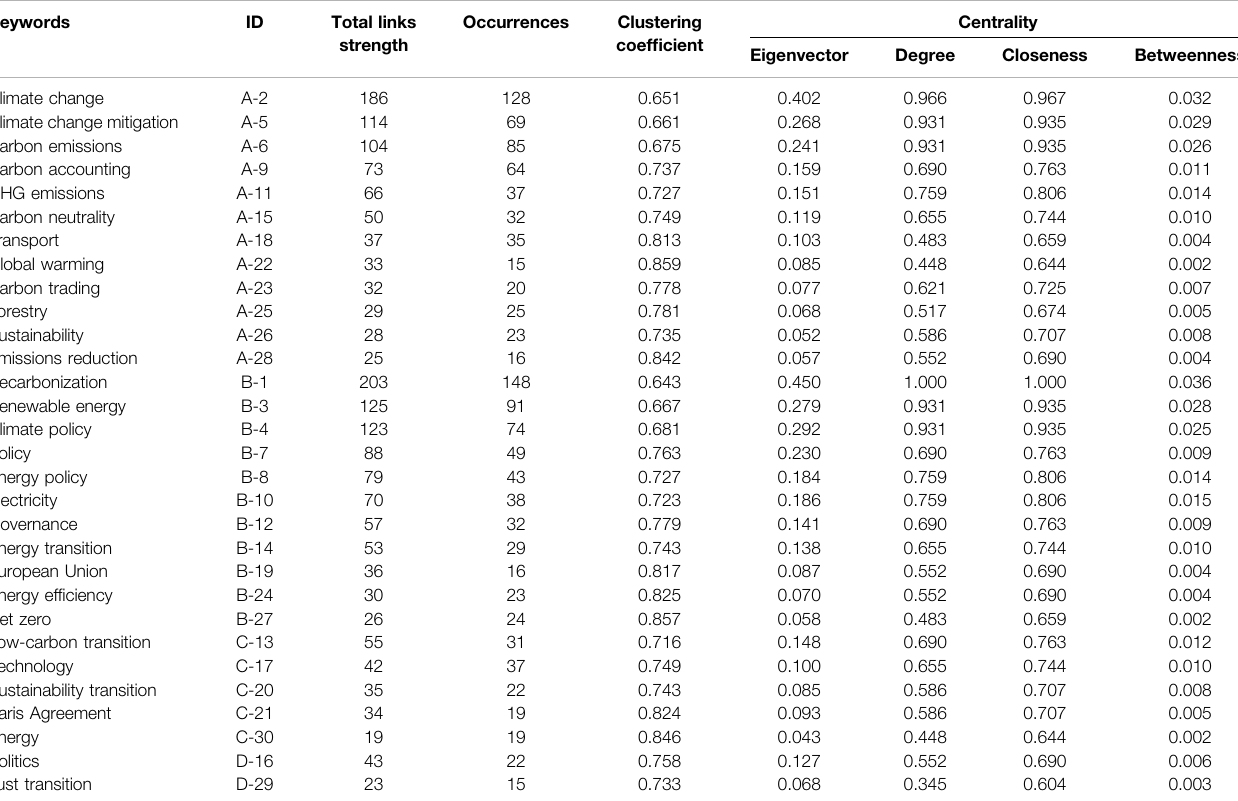
TABLE 2 | Main keywords: key scientometric metrics based on keyword co-occurrence network. Keywords